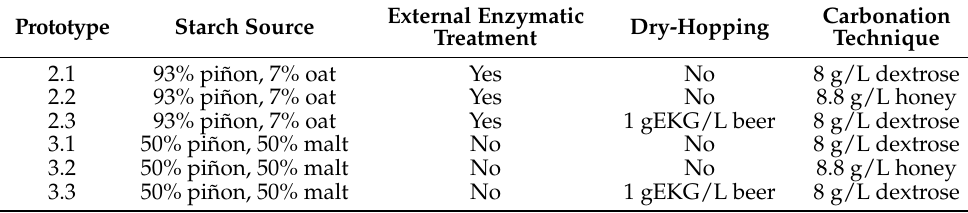
Table 3. Prototypes for general acceptability